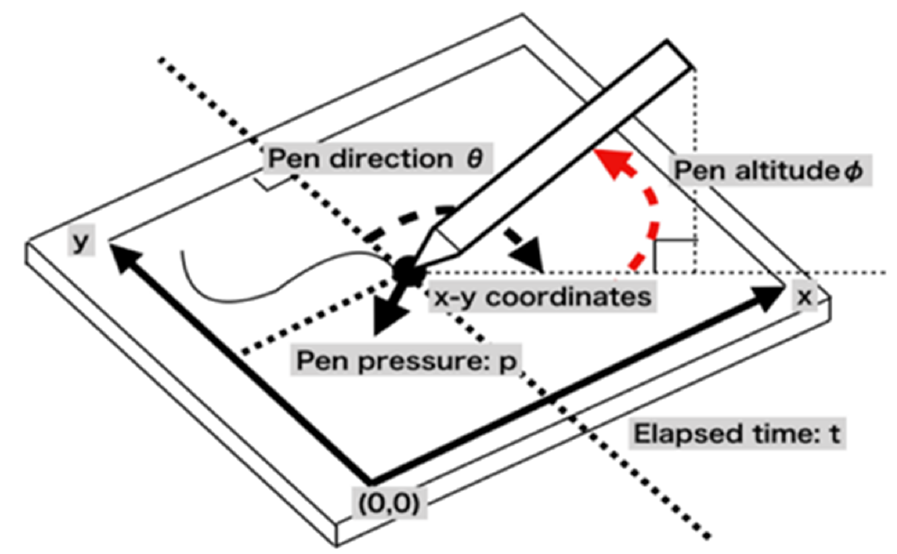
Figure 1. Pen tablet device.